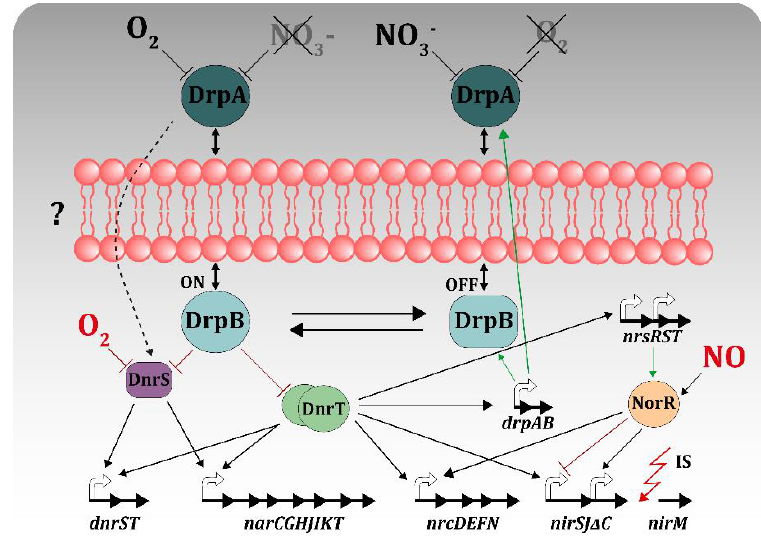
Figure 5. Regulatory circuitry controlling nitrate respiration. DnrS is the oxygen sensor of the system, being active in its absence and allowing its own expression and that of cotranscribed gene dnrT , as well as acting in the transcription of the nar operon. DnrT is a general activator needed for transcription of all the operons for nitrate respiration as well as to transcribe nir , nor and nrs operons needed for nitrite respiration in denitrifying strains of Tth, a process in which DnrS is also needed. NorR is a transcription factor that stimulates transcription of nrc, nirJ and its own operon, but represses nirS promotion in the presence of NO. DrpB activity on transcription is likely to occur through interaction with the master regulator proteins in the absence of nitrate, and releases this activity by an unknown mechanism (?) when DrpA detects nitrate in the periplasm (see the text for details).